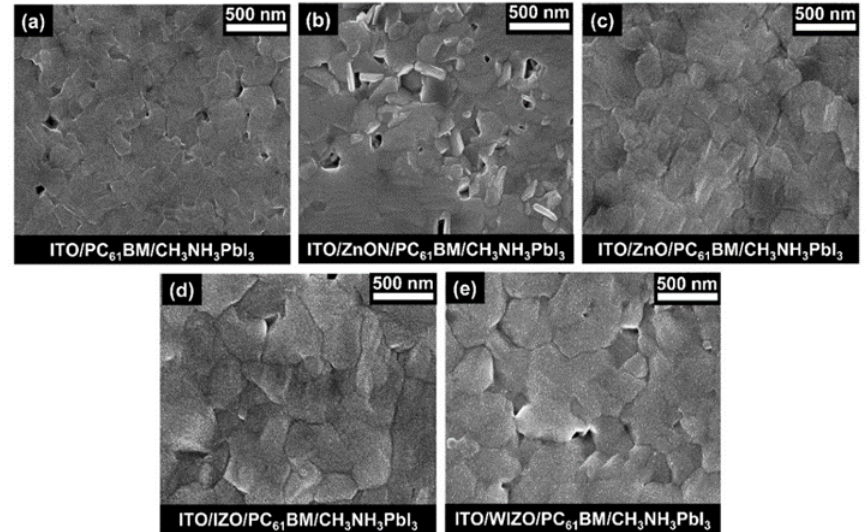
Figure 4. SEM images of CH 3 NH 3 PbI 3 thin films on PC 61 BM prepared on different metal oxides. (a) w/o ETL, (b) ZnON, (c) ZnO, (d) IZO, and (e) WIZO.